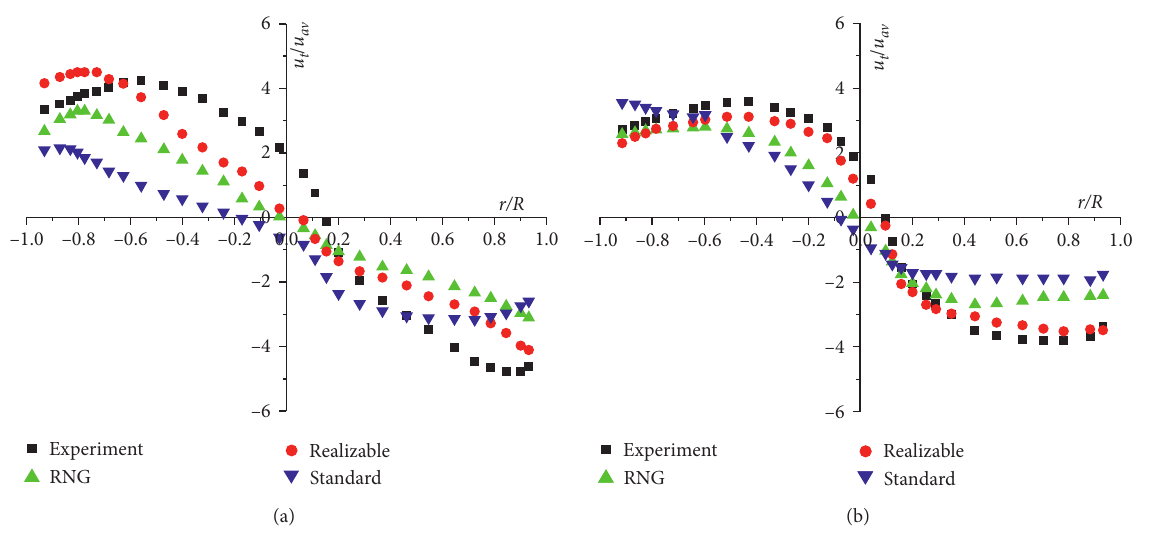
Figure 3: Tangential velocity of each section. (a) Section 1. (b) Section